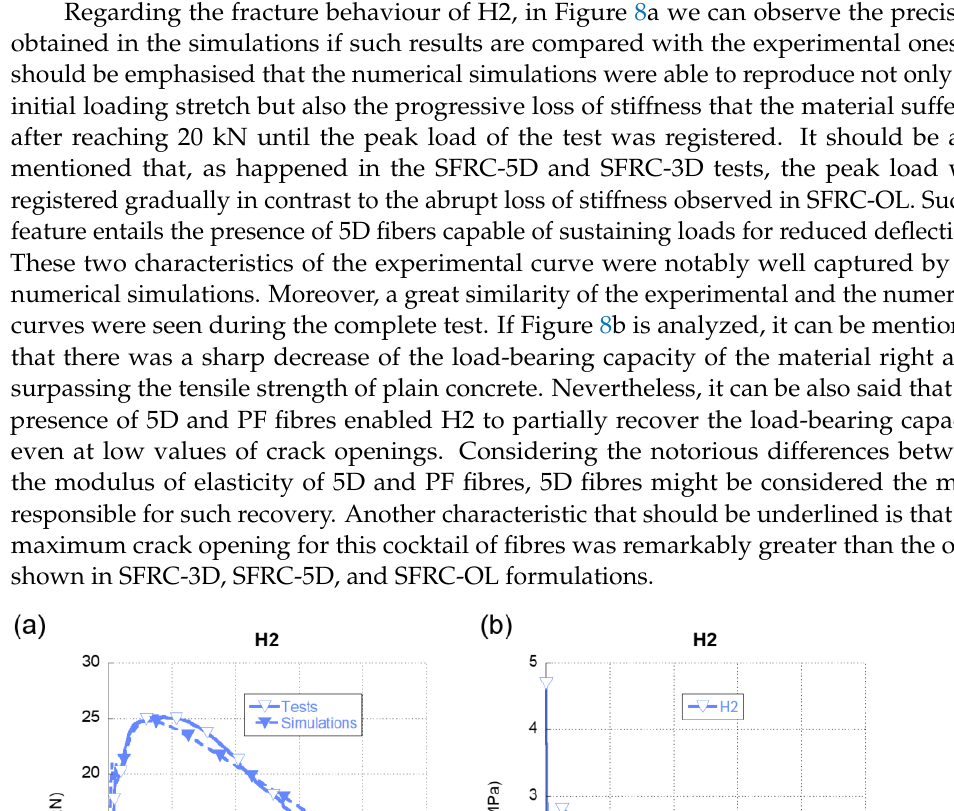
Figure 7. ( a ) Comparison of the average experimental results obtained in the fracture tests of H1 and the numerical simulation. ( b ) Softening function used in the simulation shown in ( a ).